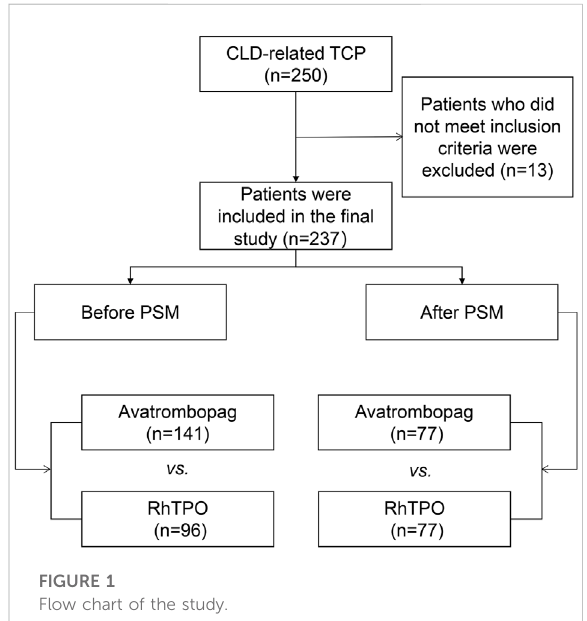
FIGURE 1 Flow chart of the